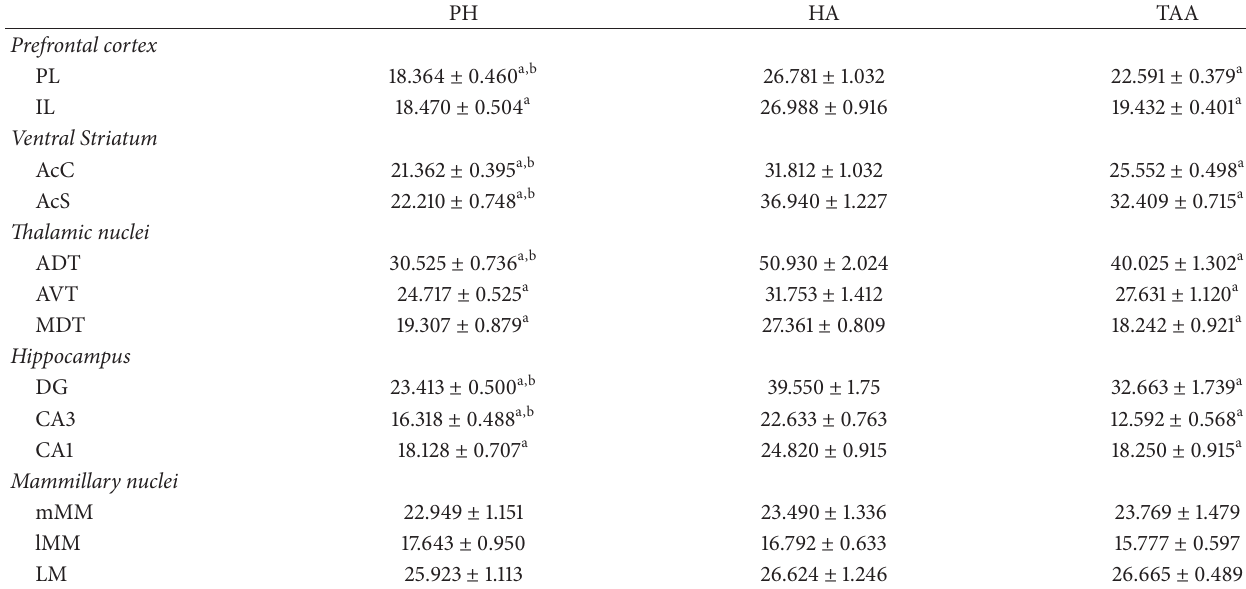
Table 1: Metabolic activity of the selected brain regions in the studied